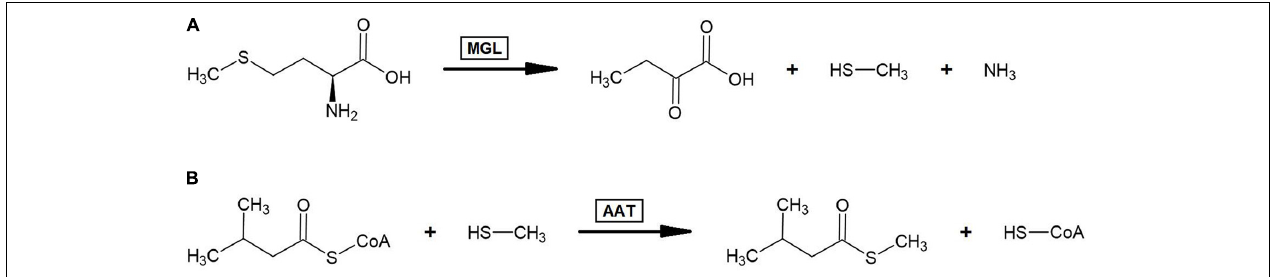
FIGURE 4 | Proposed biosynthesis pathway for S -methyl branched-chain thioester volatiles. (A) Breakdown of L-methionine to α -ketobutanoate, methanethiol, and ammonia by the action of L-methionine- γ –lyase (MGL). (B) Formation of S -methyl branched-chain thioesters via alcohol acyltransferase (AAT) mediated condensation of methanethiol with branched-chain acyl-CoAs. This panel illustrates this process occurring with 3-methylbutyl-CoA and yielding S -methyl 3-methylbutanethioate since that was the only S -methyl branched-chain thioester volatile identified across the 175 fruit volatile studies examined in this review; however, this process could theoretically yield S -methyl 2-methylpropanethioate and S -methyl 2-methylbutanethioate from 2-methylpropyl-CoA and 2-methylbutyl-CoA, respectively.